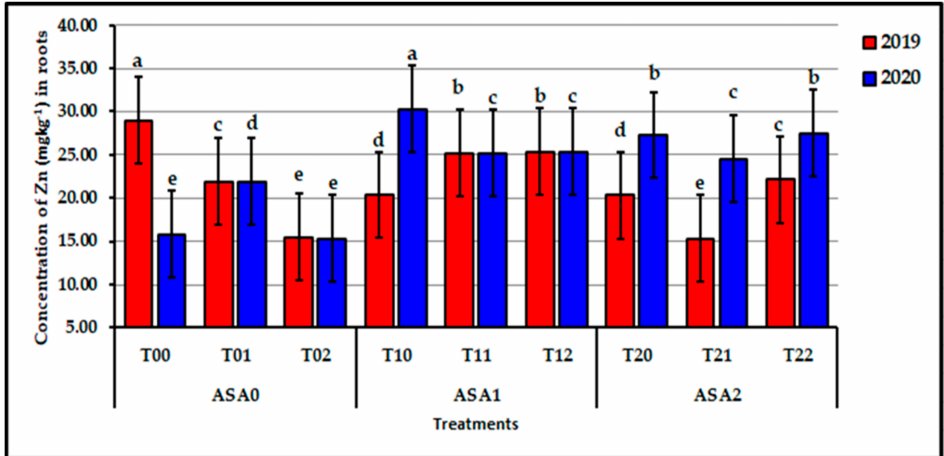
Figure 9. Influence of interaction between zinc oxide nanoparticles and ascorbic acid on root Zn content of stressed sweet potato plants in 2019 and 2020 seasons. Bars with a different letter indicate significant difference between treatments at p ≤ 0.05.